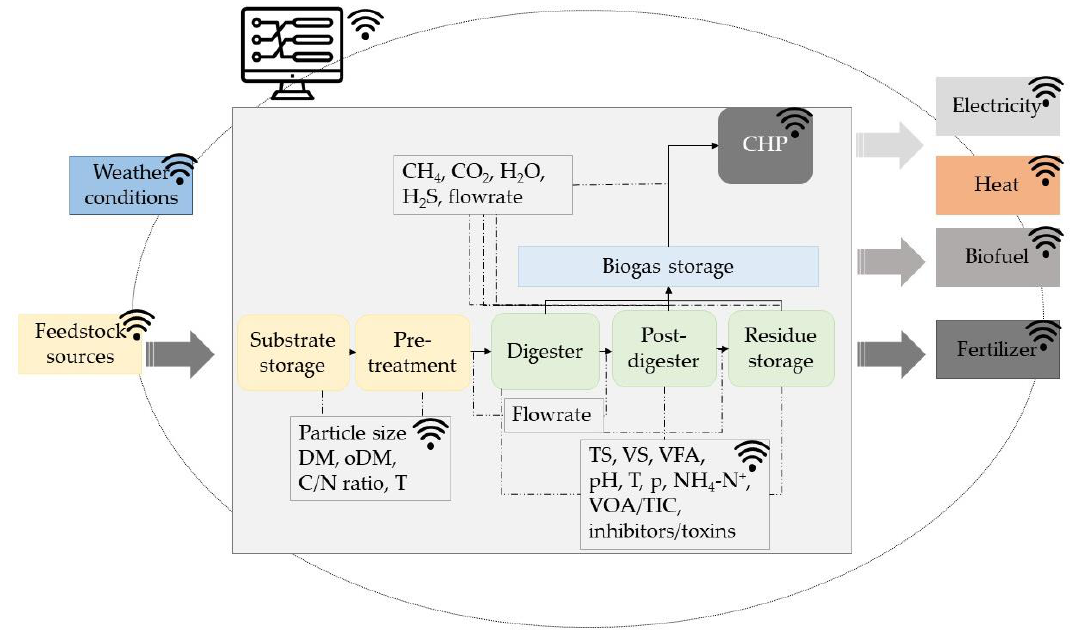
Figure 4. Integration of AI into the AD operation for flexible and efficient production. p: pressure.